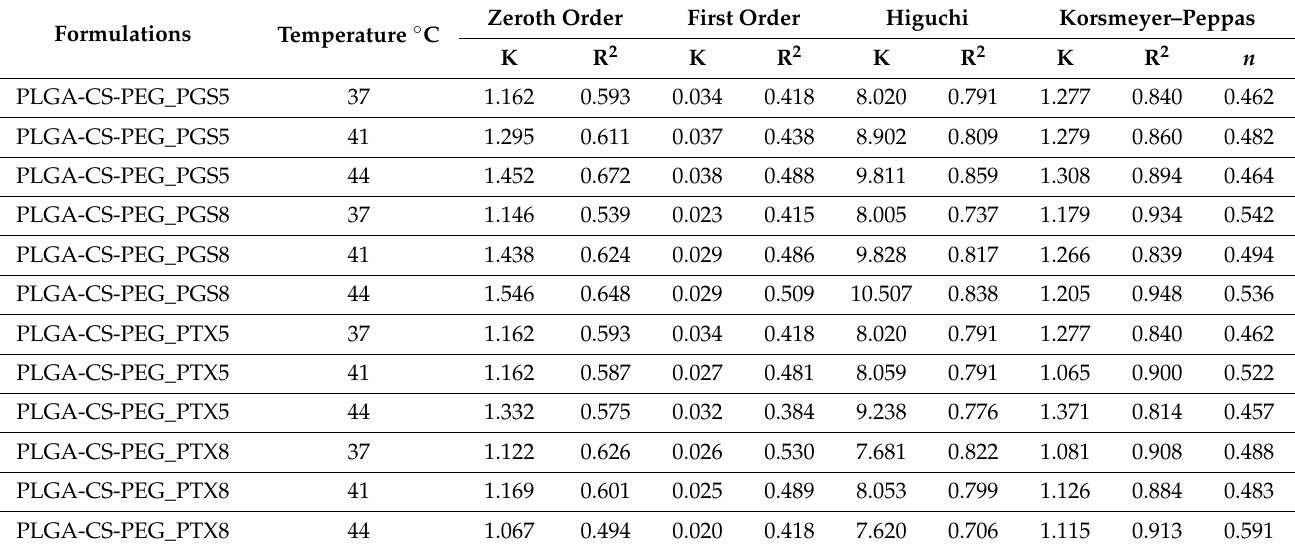
Table 4. The kinetic constant (K), correlation coefficient (R 2 ) and release exponent ( n ) of kinetic data analysis of drug released from drug-loaded PLGA-CS-PEG microsphere formulations. Formulations